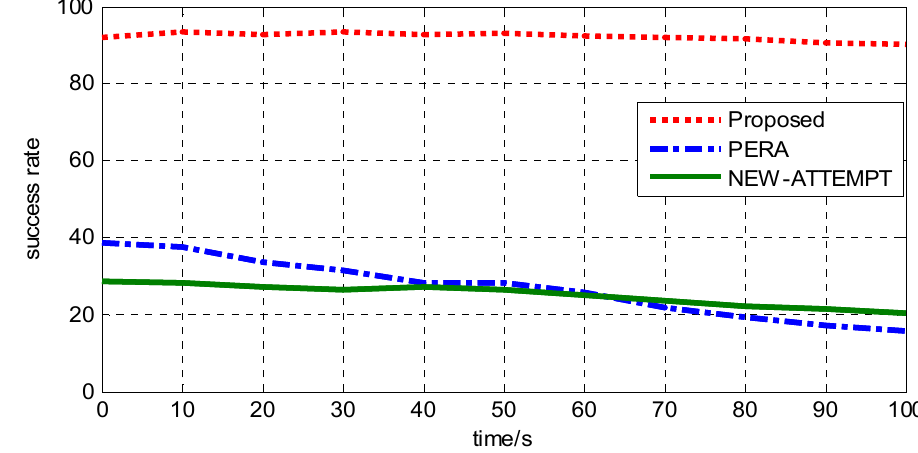
Figure 8. Analysis of the reliable transmission of P1 priority data.